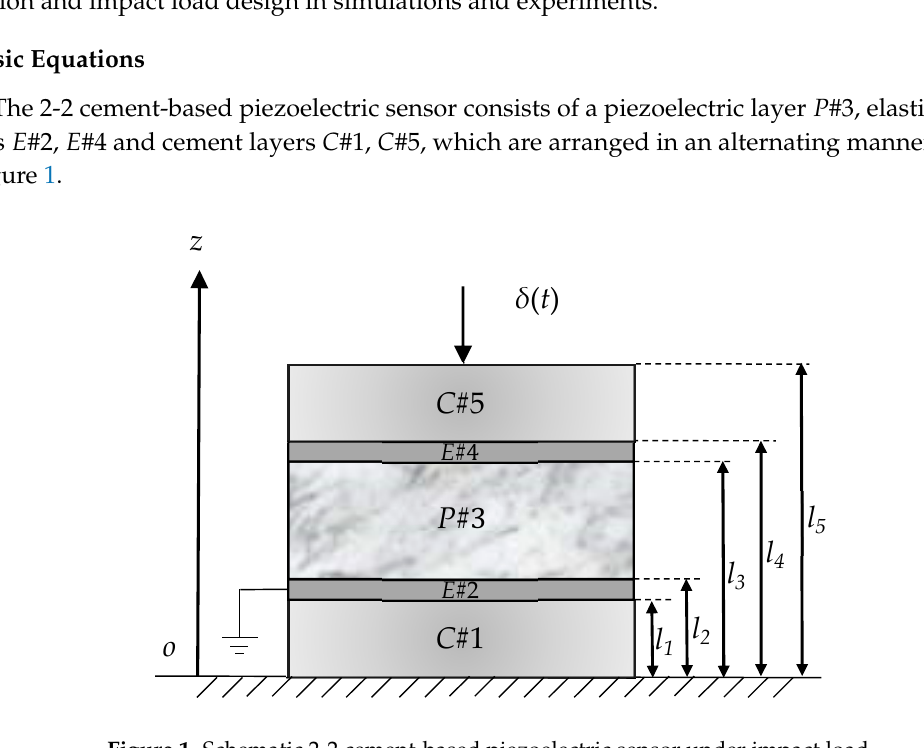
Figure 1. Schematic 2-2 cement-based piezoelectric sensor under impact load.